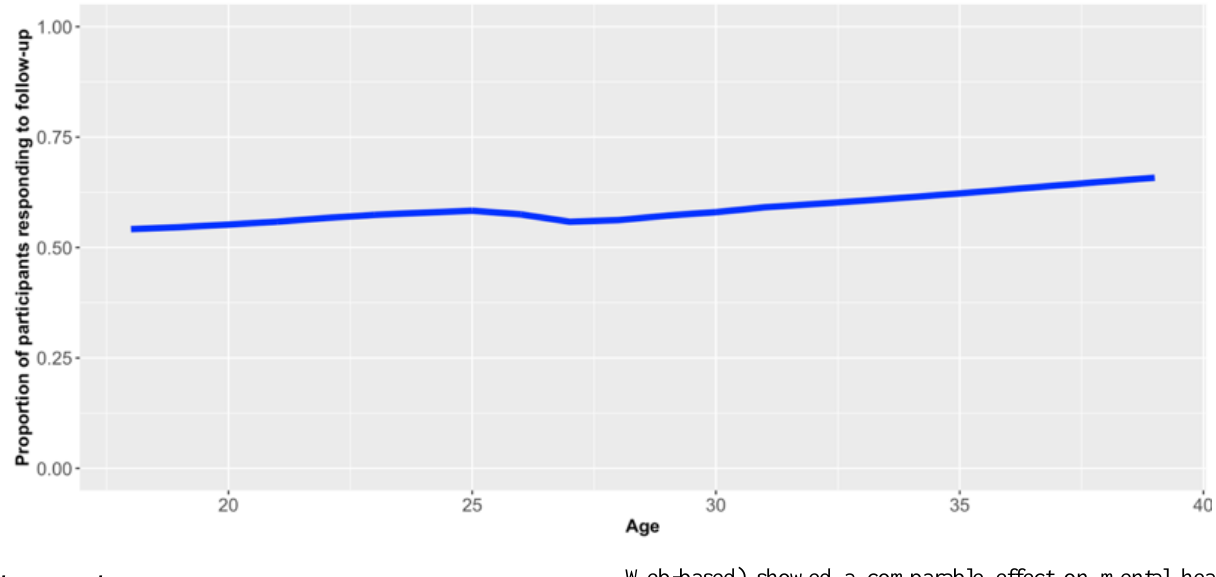
Figure 4. Locally weighted scatterplot smoothing: age against proportion of participants responding to follow-up, including only participants aged less than 40 years at